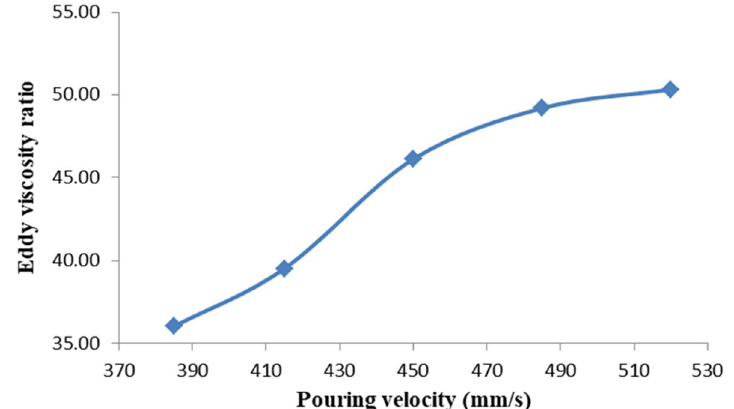
Fig. 10 Eddy viscosity ratio variation with pouring